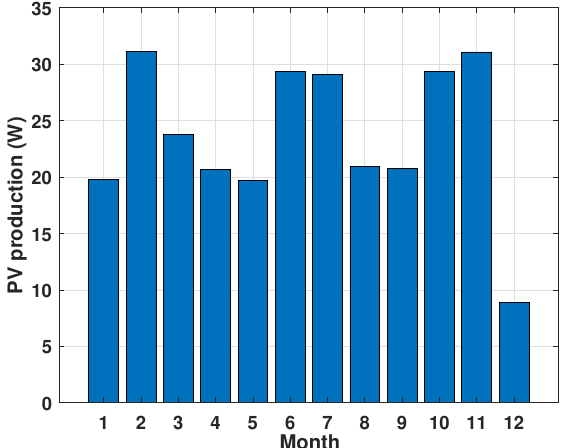
Figure 23. PV monthly power production.